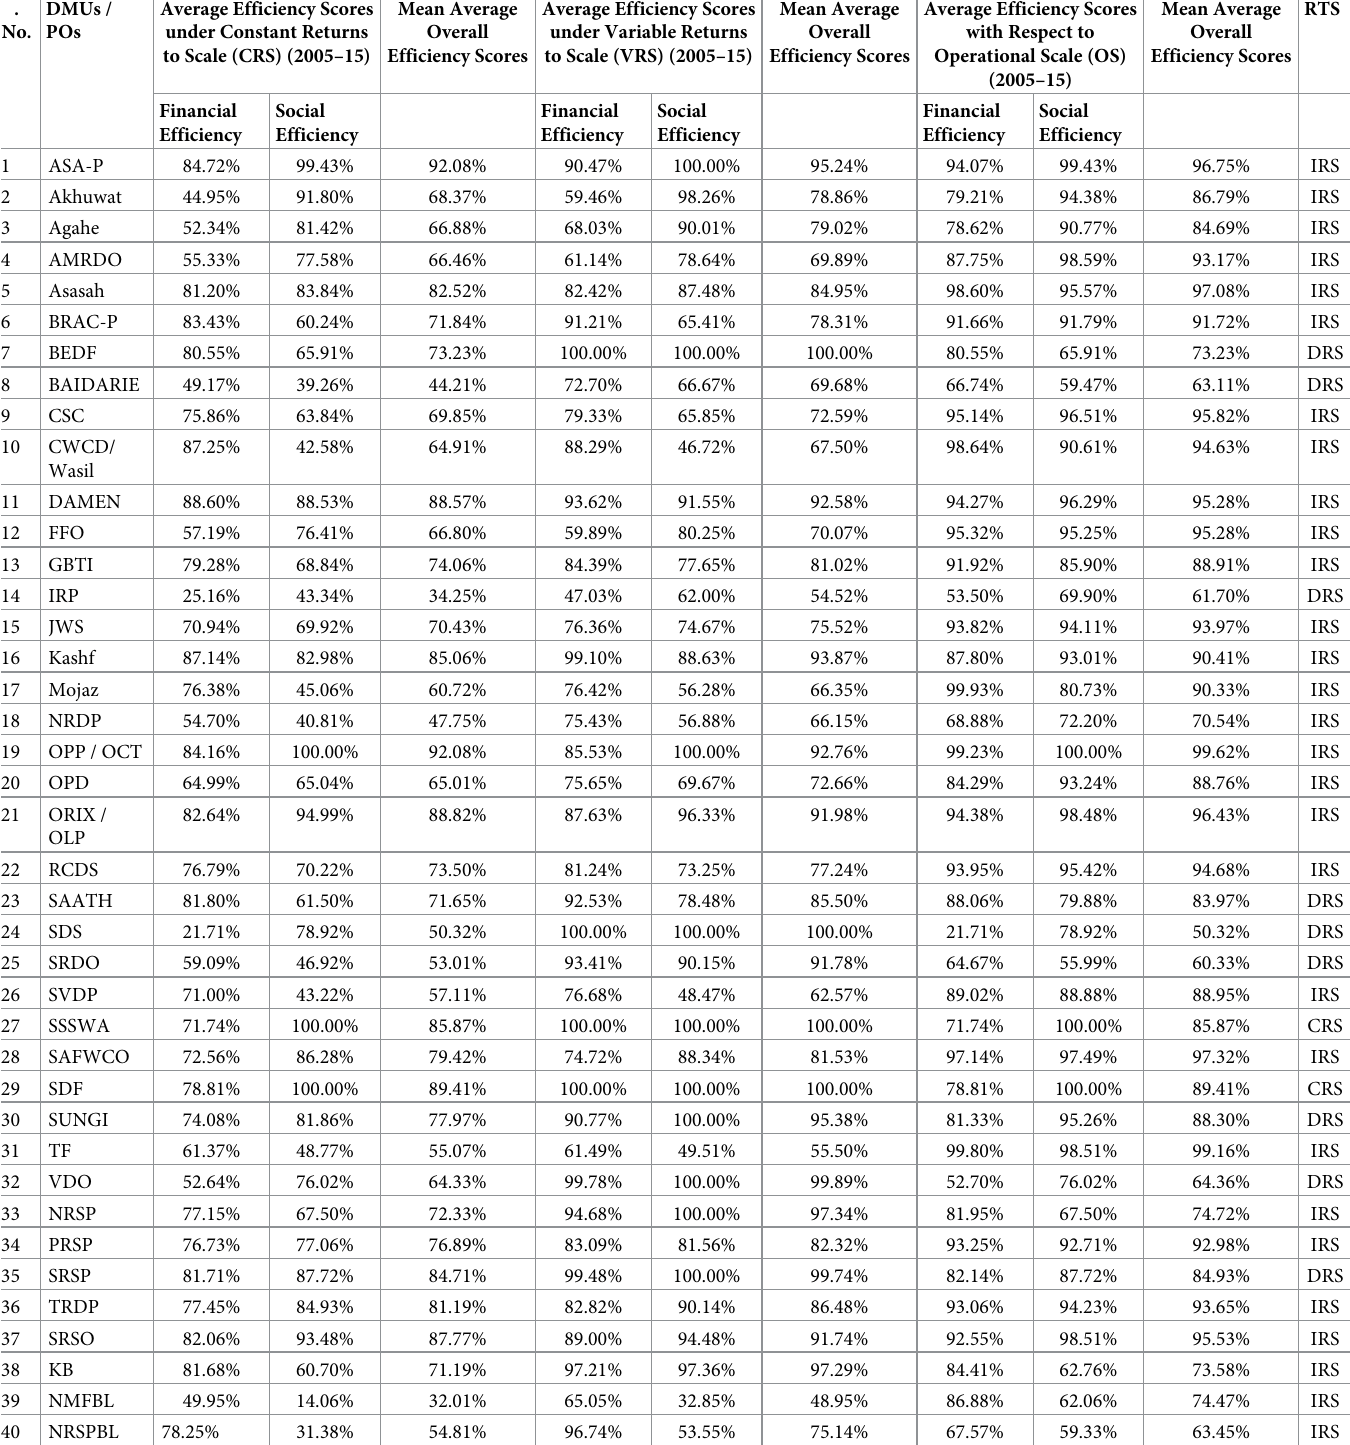
Table 7. Average financial and social efficiency scores of the POs under constant returns to scale (CRS), variable return to scale (VRS) and with respect to opera- tional scale. . DMUs / No.